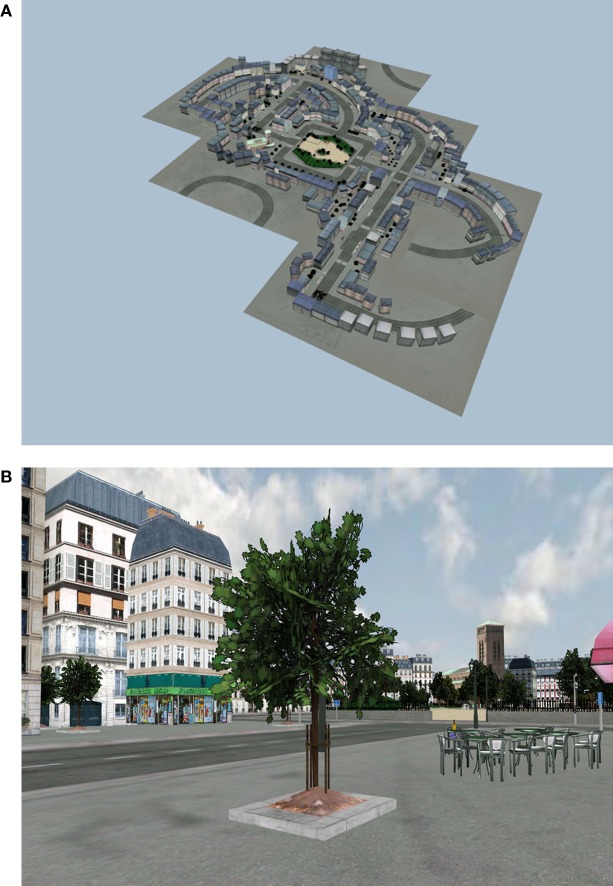
The urban environment created by the LMC unit. (A) Map of the virtual 3D town. (B) View of a street in the virtual town.